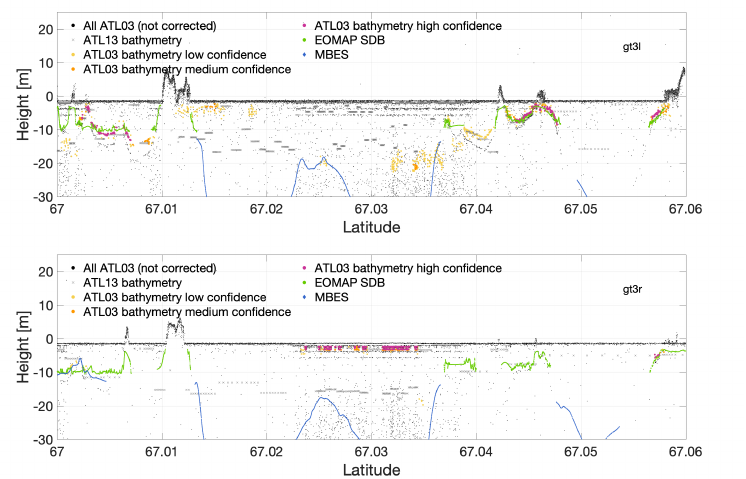
Figure 15. Figure showing the different bathymetry profiles as well as all the ATL03 photon data from ICESat-2 track 529. The ICESat-2 data were acquired on 1 February